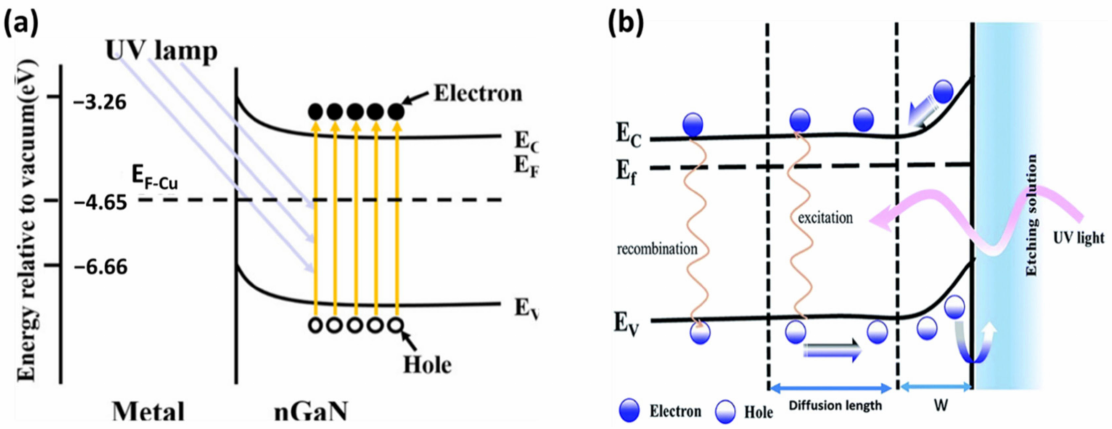
Figure 6. Energy band diagram of ( a ) GaN and ( b ) InGaN. Reproduced from [54] and [46] (( a ) and ( b ) respectively), with permission from Copyrights Elsevier, 2019, and Royal Society of Chemistry,